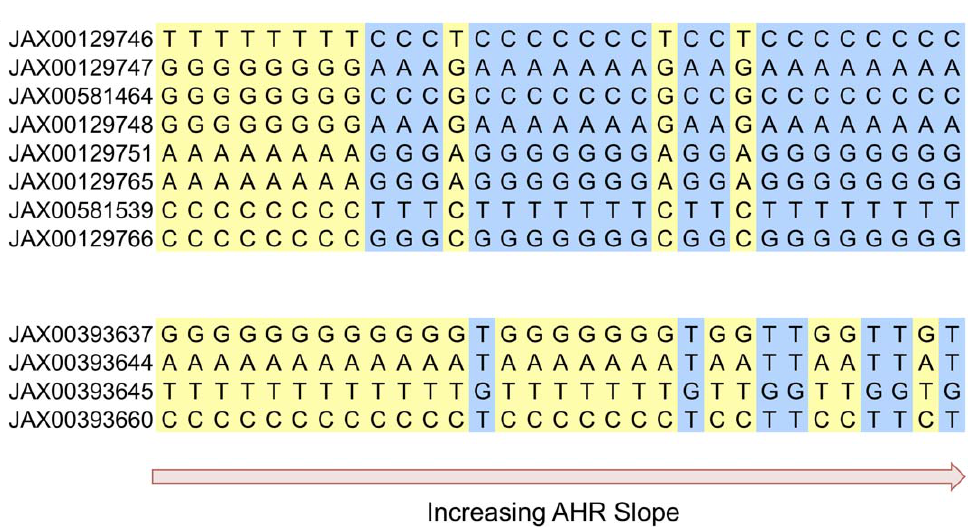
Figure 5. Mouse genotypes for SNPs with P-value , 0.001 in the top two association regions. A) Kcnip4 and B) Pdzd2/Golph3/Mtmr12/Zfr. Each column corresponds to a mouse strain, ordered as displayed in Figure 2, such that AHR slope increases from left to right.